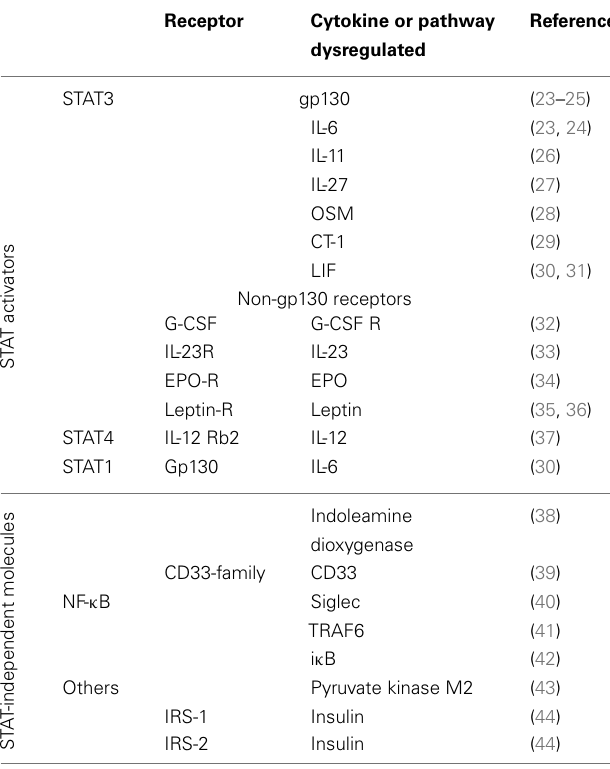
Table 1 | Molecules regulated by